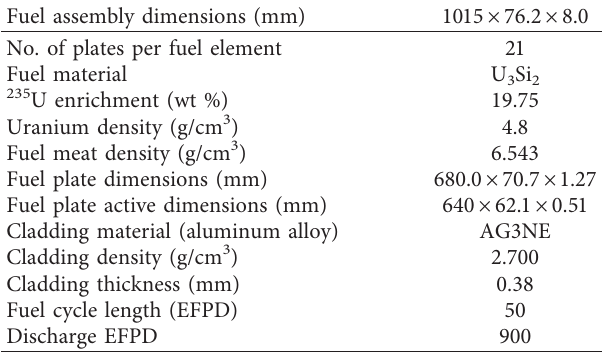
Figure 2: TRITON 2-D model of the JRTR fuel assembly showing the fuel (red), aluminum clad (green), and water coolant (blue). Table 2: Technical specifications and material data of the fuel